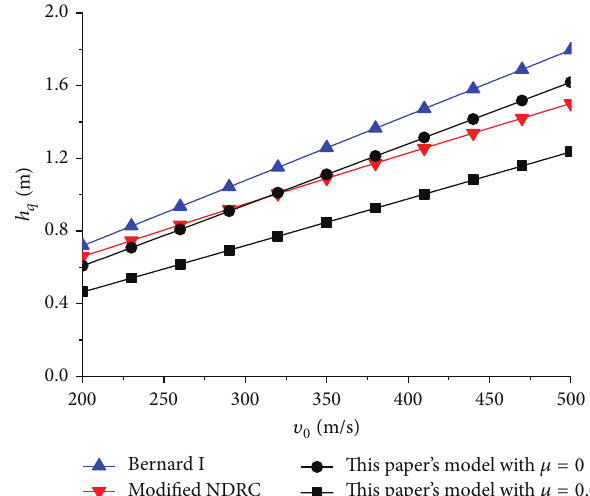
Figure 12: The predicted results for T-3 and